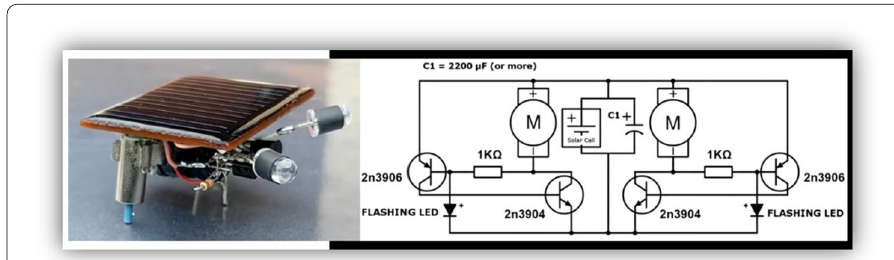
Fig. 3 Robot BEAM Photopoper(Tasi Geri,